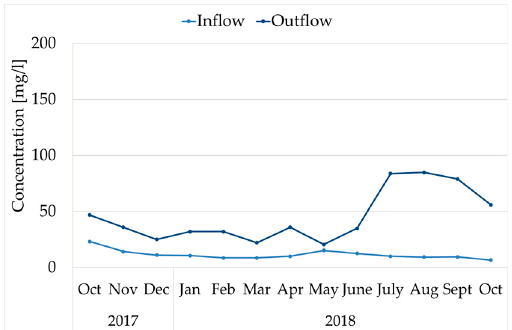
Figure 11. Chloride concentration in inflow and outflow water at Site B.